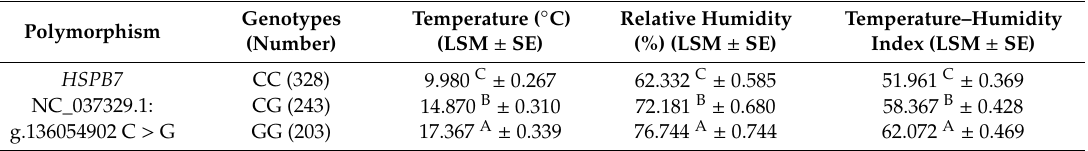
Table1. Associationofgenotypesofthe HSPB7 NC_037329.1: g.136054902C >